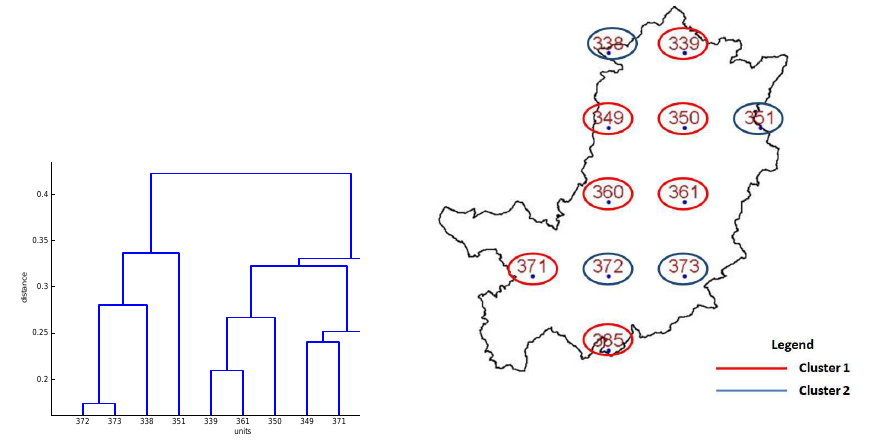
Figure 5 – Dendrogram for Ward’s method applied to the 11 sites.